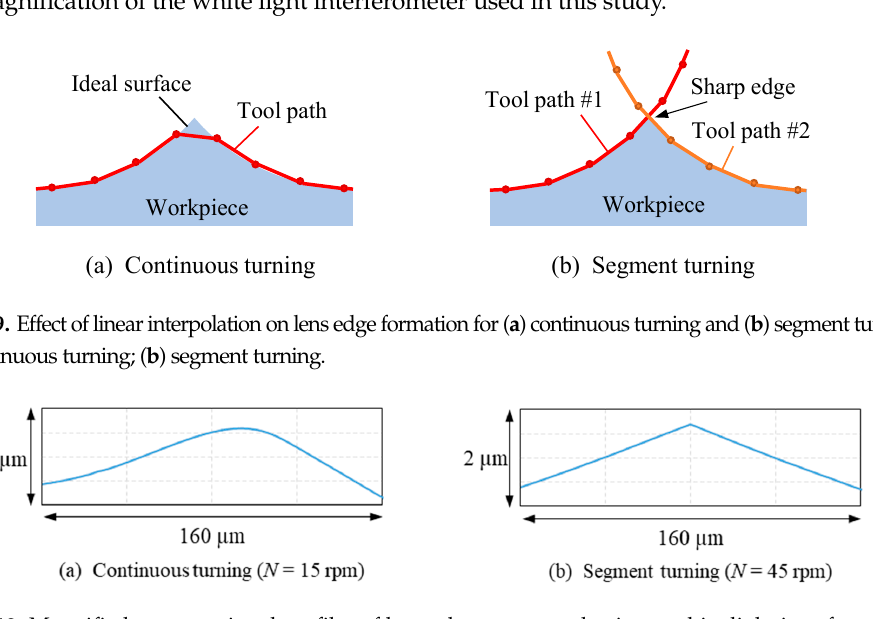
Figure 10. Magnified cross-sectional profiles of lens edges measured using a white light interferometer, showing a blunt edge for ( a ) continuous turning and a sharp edge for ( b ) segment turning. ( a ) Continuous turning ( N = 45 rpm); ( b ) segment turning ( N = 45 rpm).